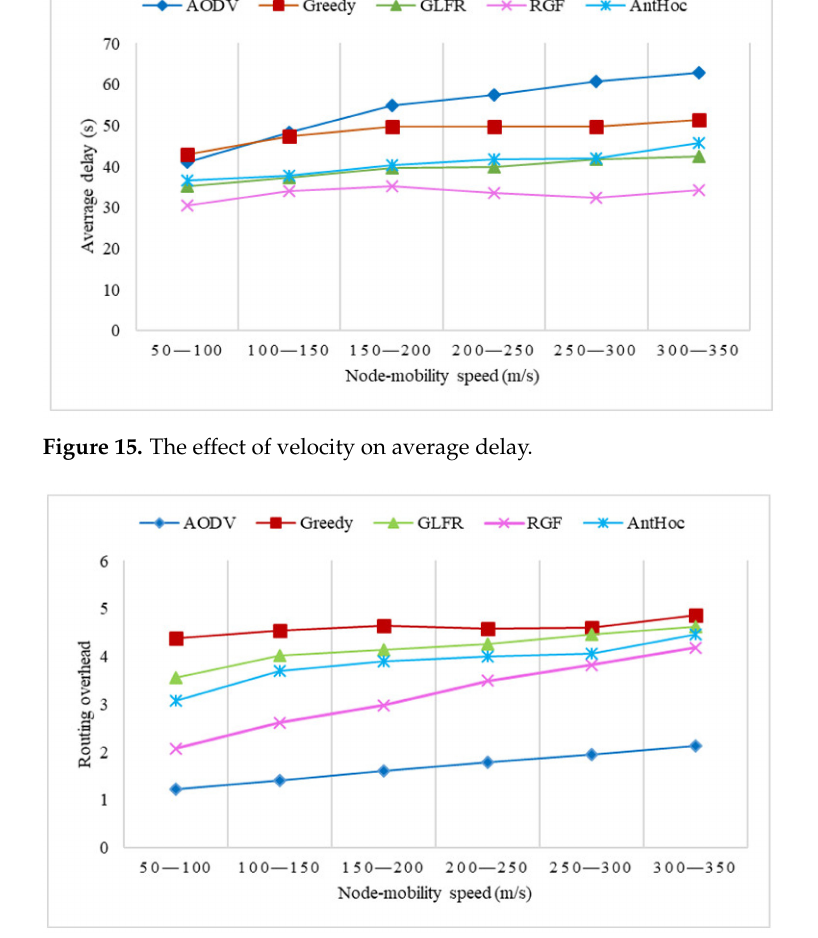
Figure 16. The effect of velocity on routing